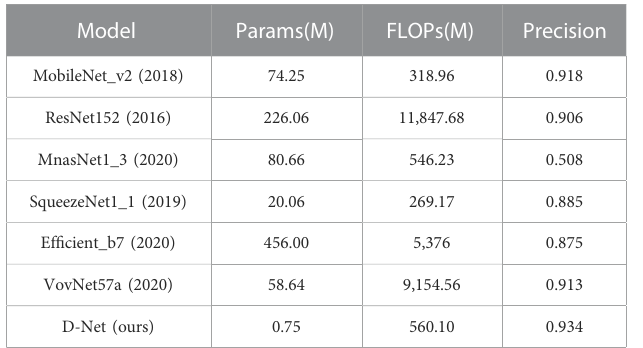
TABLE 3 Comparison of D-Net and CNN model data. MobileNet, MnasNet, SqueezeNet, and Ef fi cient are lighter modeling methods, while ResNet and VovNet are among the better performing methods.